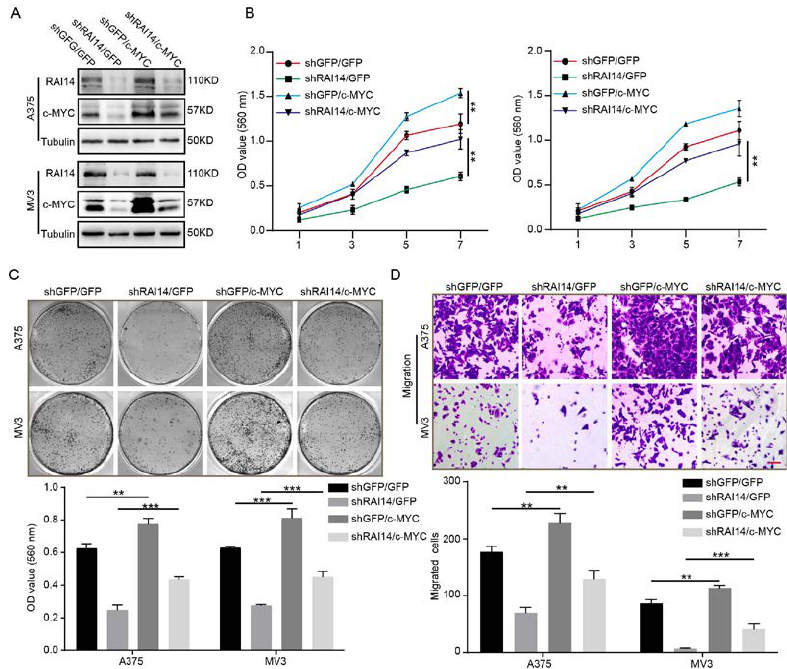
Figure 4. The overexpression of c-MYC significantly restored cell proliferation and migration of RAI14 knockdown melanoma cells. ( A ) The protein levels of RAI14 and c-MYC in the indicated melanoma cells were detected by WB assay. ( B , C ) The effect of overexpression of c-MYC on the proliferation of melanoma cells of the RAI14 knockdown group was examined by MTT assay and plate clone assay. ( D ) The effect of c-MYC overexpression on the migration ability of RAI14 knockdown melanoma cells was detected by transwell assay. Scale bar = 50 μm. All data were expressed as mean ± SD. One-way ANOVA was performed to analyze significance. ** p < 0.01, *** p < 0.001.